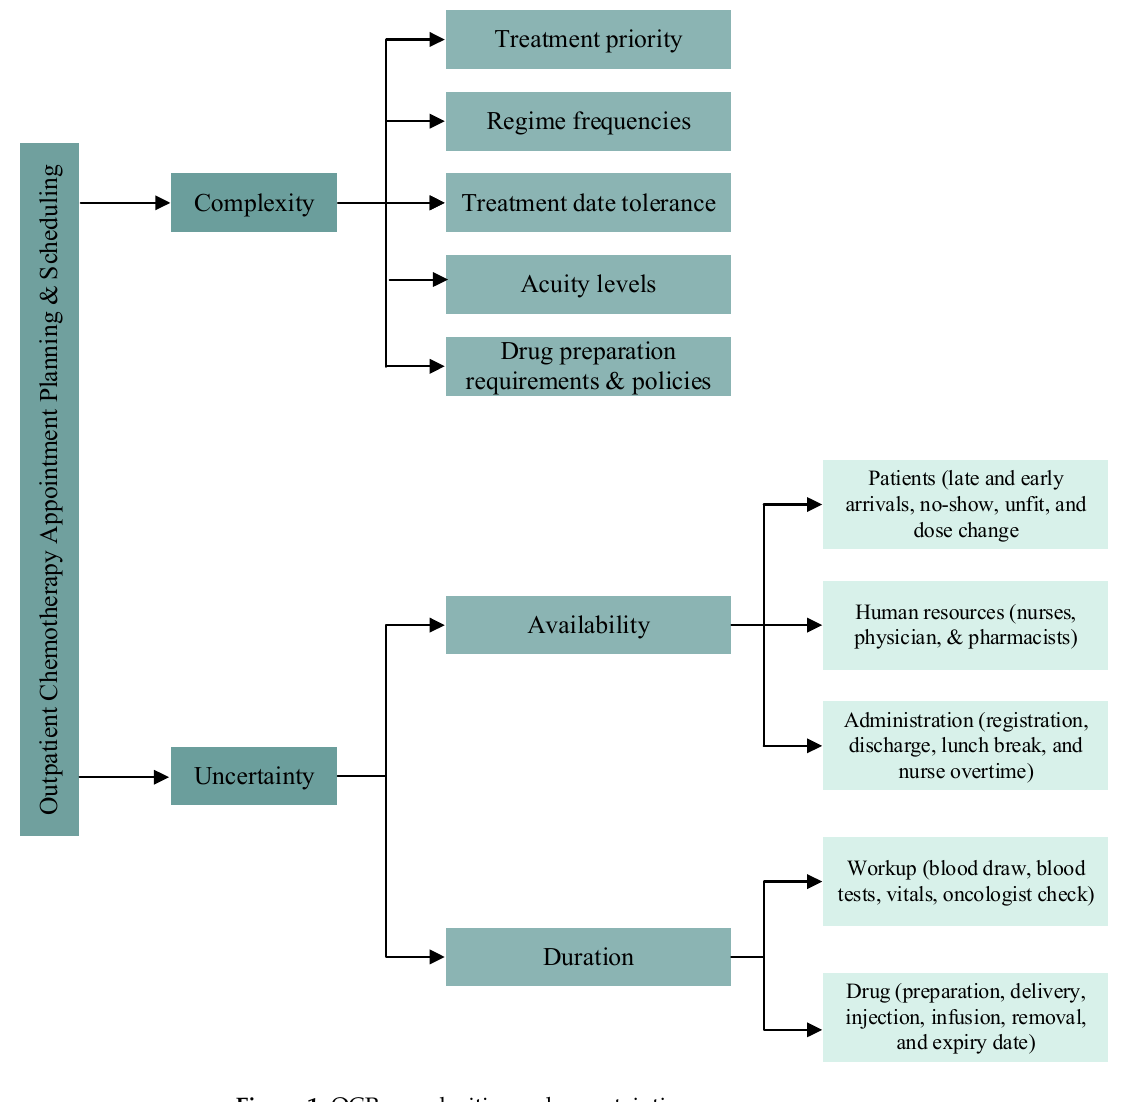
Figure 1. OCP complexities and uncertainties.